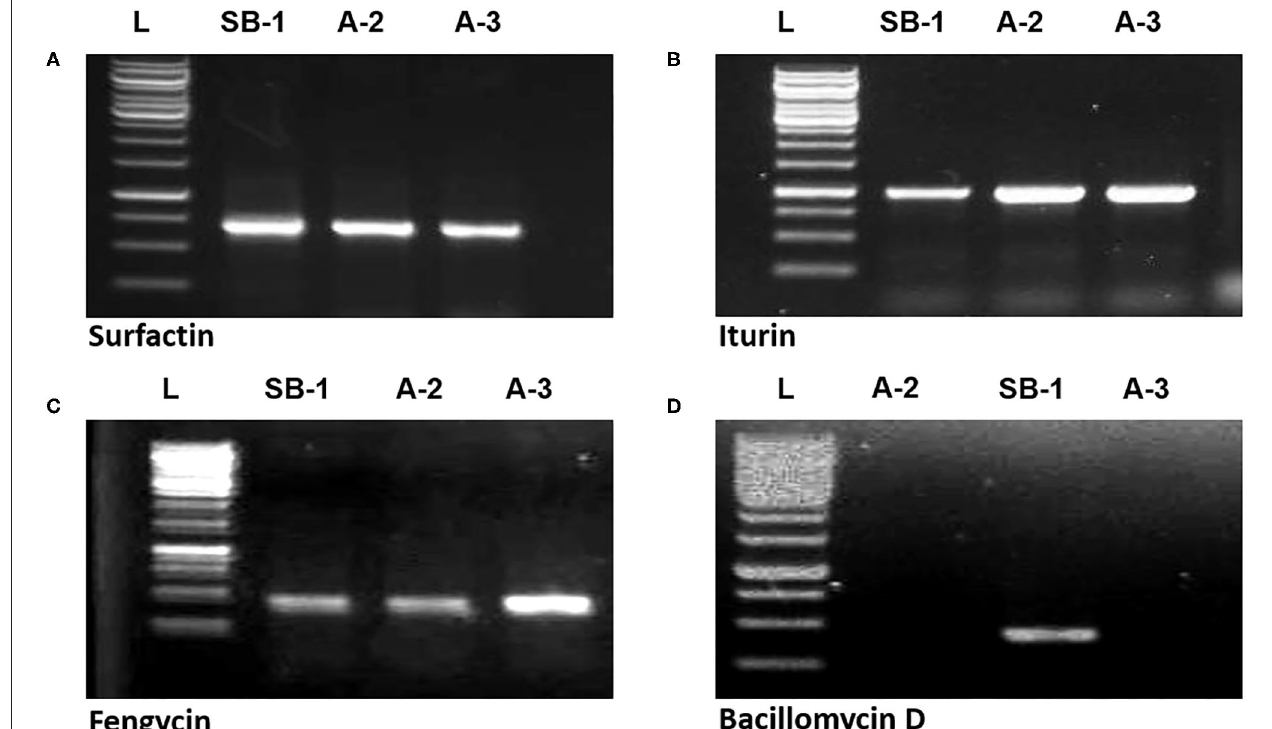
FIGURE 4 | Amplification of sfp (A) , ituD (B) , fen (C) , and bmy (D) genes of Bacillus spp. strains, L represents 1kb DNA ladder.